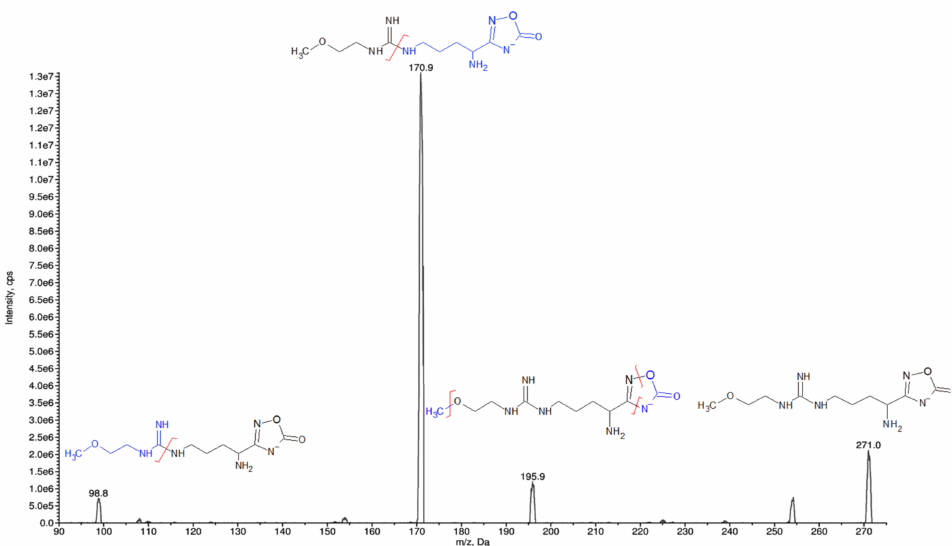
Figure 3. SRM fragmentation pattern of ZST152 obtained by tandem mass